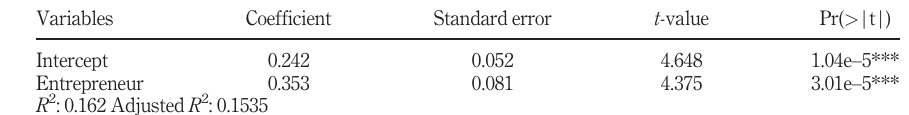
Table VI. Entrepreneurs ’ job satisfaction